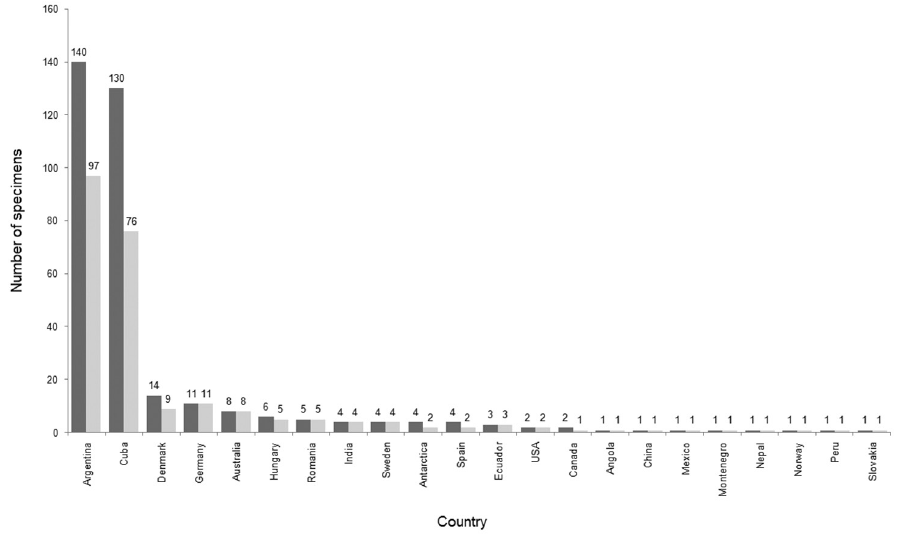
Figure 2. The geographic distribution of the Šariš Museum in Bardejov exotic bird collection with number of bird specimens (dark grey) and species (light grey) collected from each country.